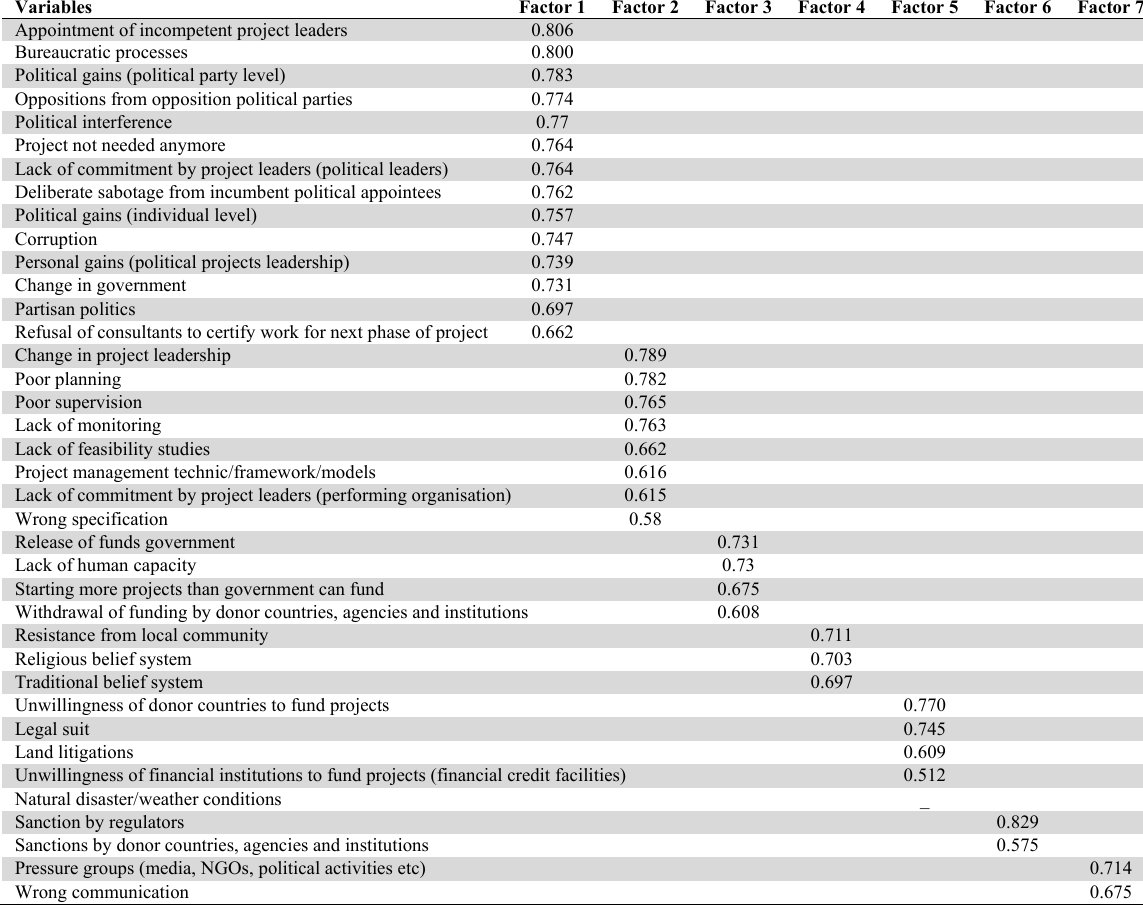
Varimax rotated component